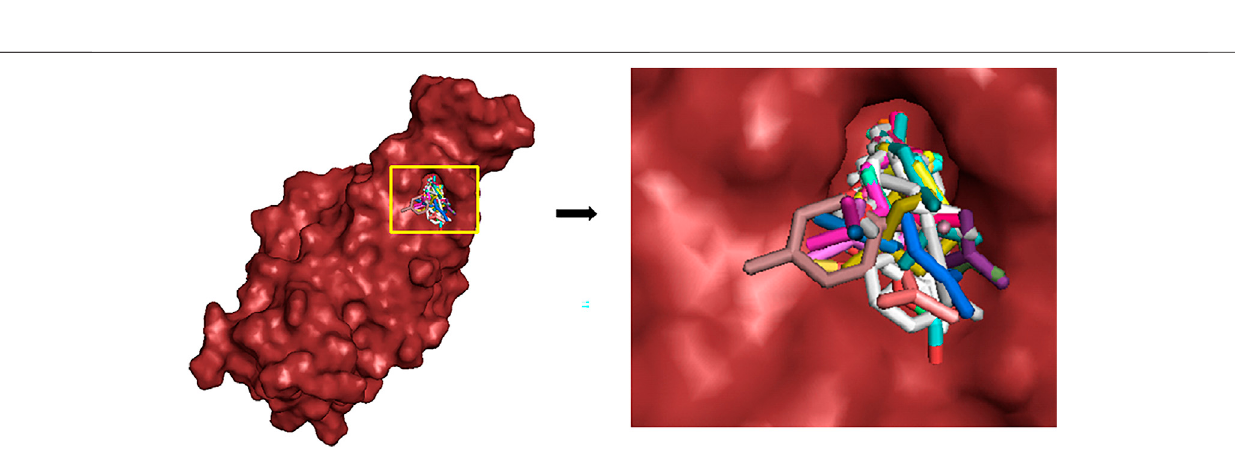
Frontiers in Chemistry |